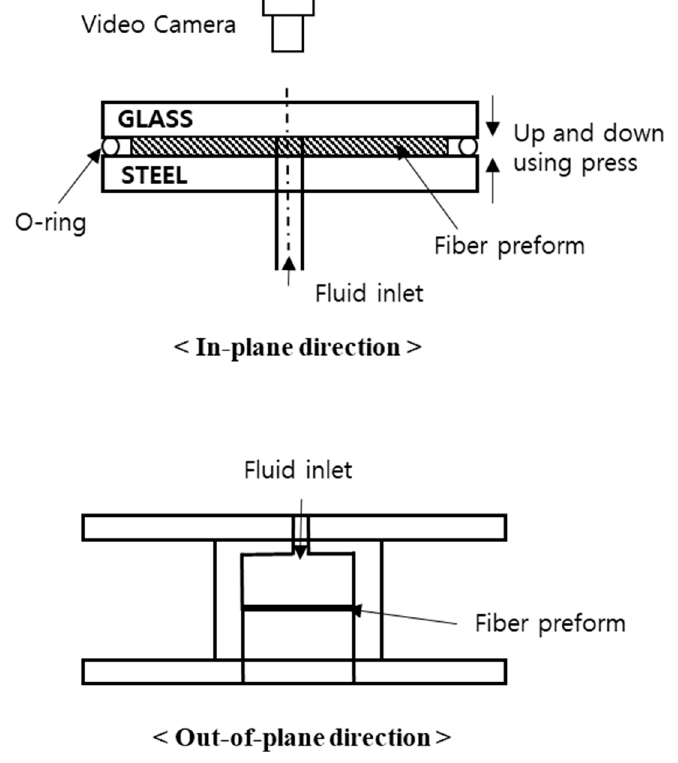
Figure 1. Preforming process for the carbon fabric preform using vacuum bagging.